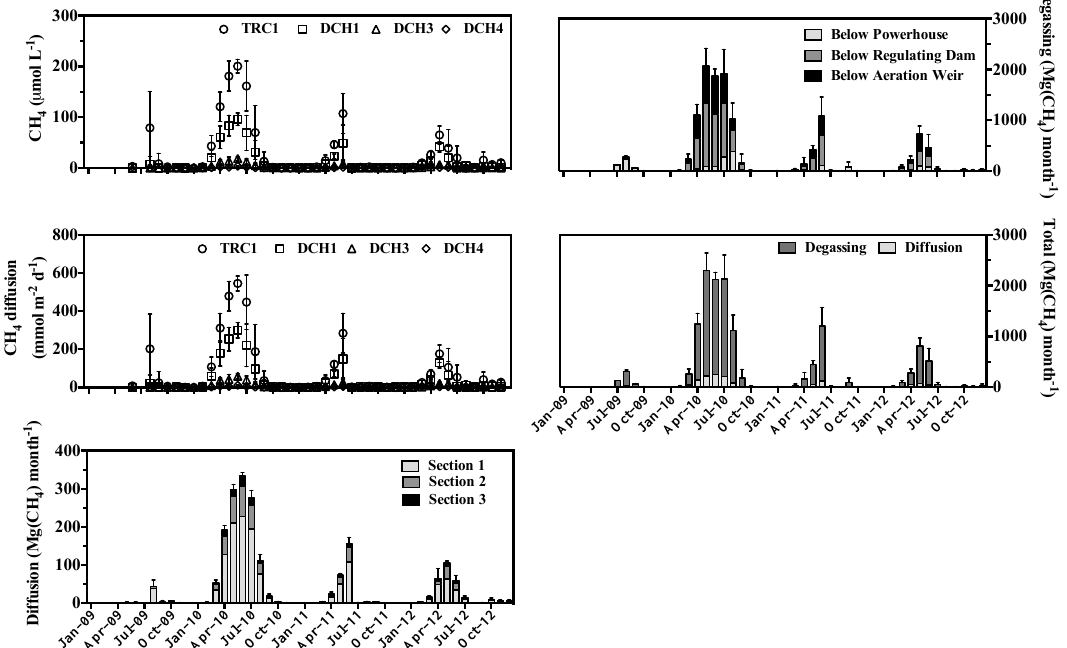
Figure 4. Methane concentrations and emissions downstream of the powerhouse of the Nam Theun 2 Reservoir between 2009 and 2012. (a) Time series of CH 4 concentrations at stations TRC1, DCH1, DCH3, and DCH4, (b) diffusive fluxes at stations TRC1, DCH1, DCH3, and DCH4, (c) emissions by diffusive fluxes in sections 1, 2, and 3 (see Fig. 1), (d) degassing downstream of the powerhouse, the regulating dam and the aeration weir, and (e) total emissions by degassing and diffusion downstream of the Nakai Dam.